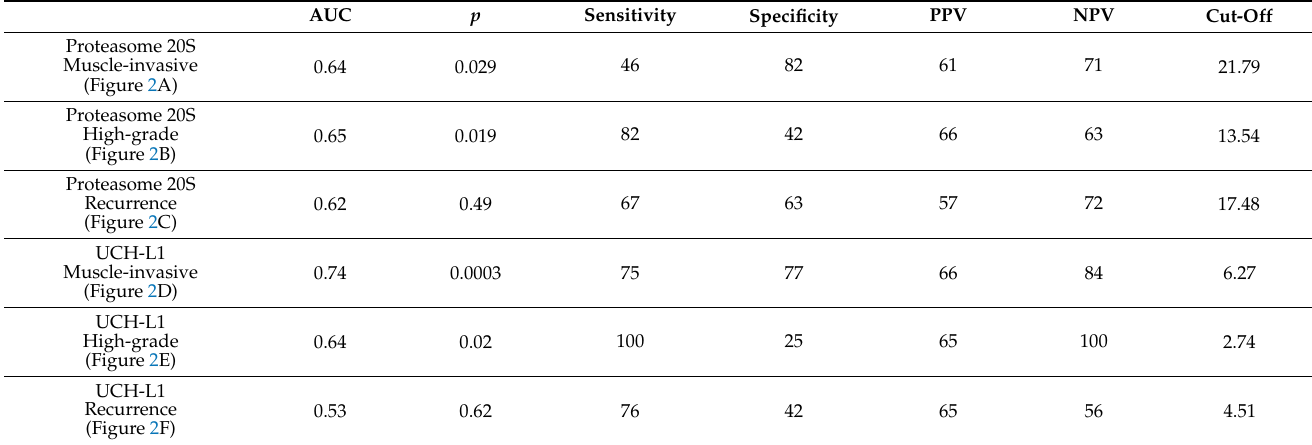
Table 5. Diagnostic efficiency of serum 20S proteasome and UCH-L1.